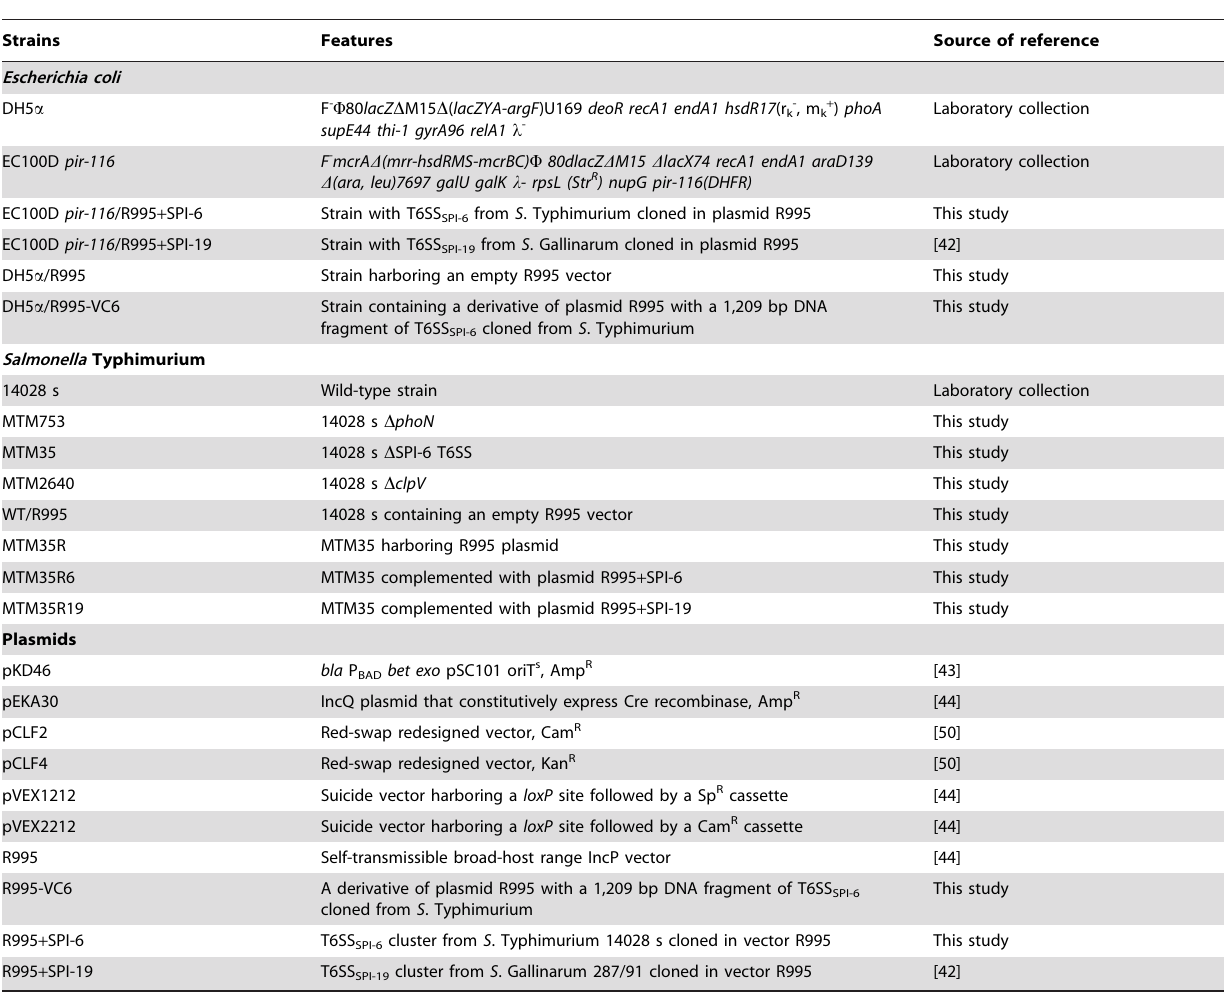
Table 1. Strains and plasmids used in this study.